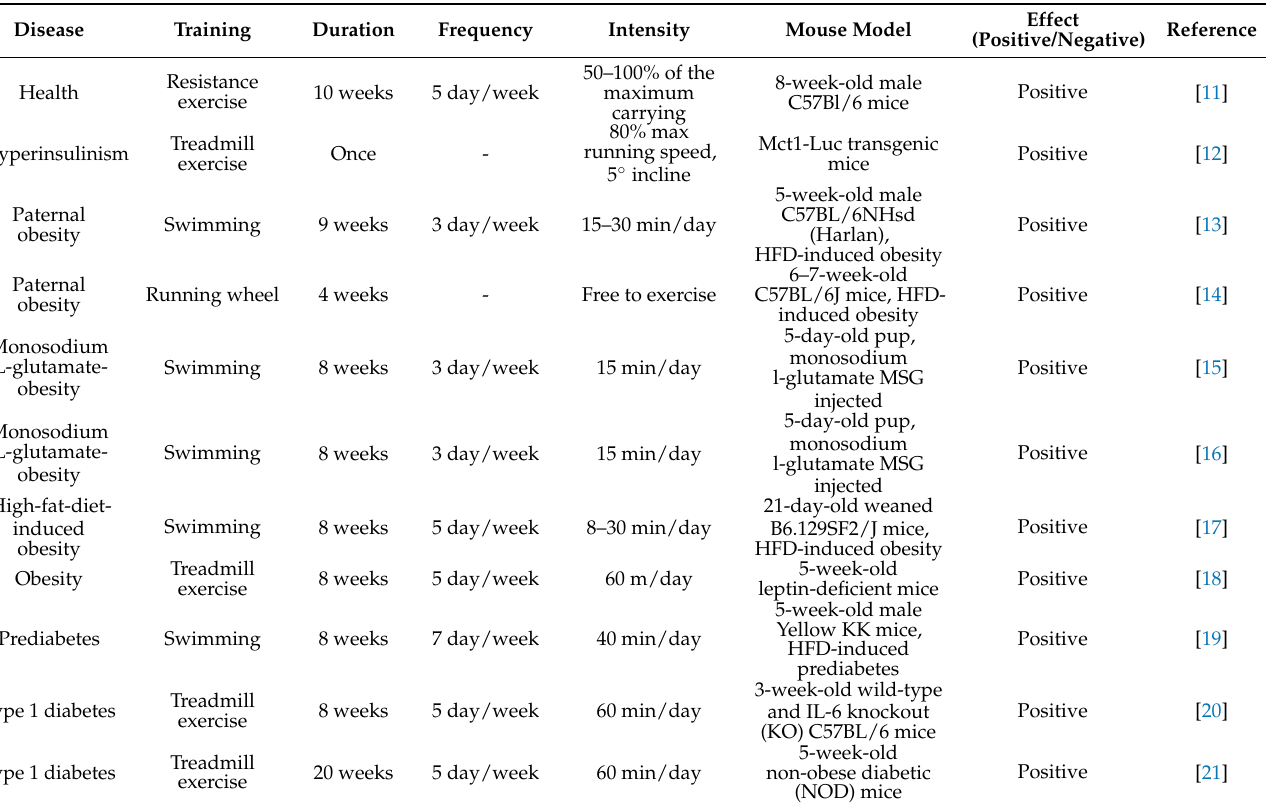
Table 1. Exercise intervention characteristics of included mice model